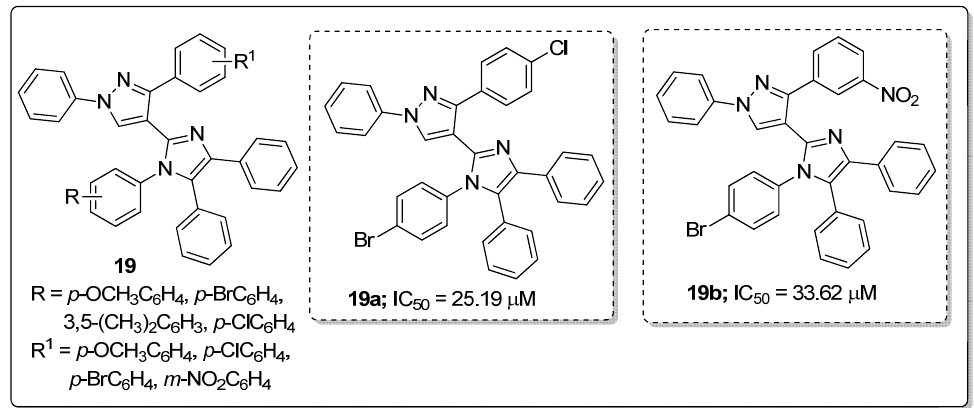
Figure 22 . Most active pyrazole ‐ imidazole hybrids 19a and 19b as α‐ glucosidase inhibitors. Figure 22. Most active pyrazole-imidazole hybrids 19a and 19b as α -glucosidase